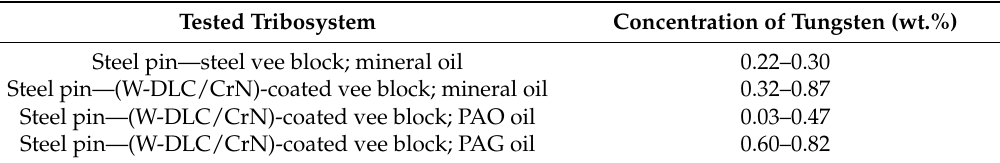
Table 3 compiles the results of the EDS analysis of tungsten on the worn surfaces of the pins. Table 3. The traces of tungsten on the worn surfaces of the test